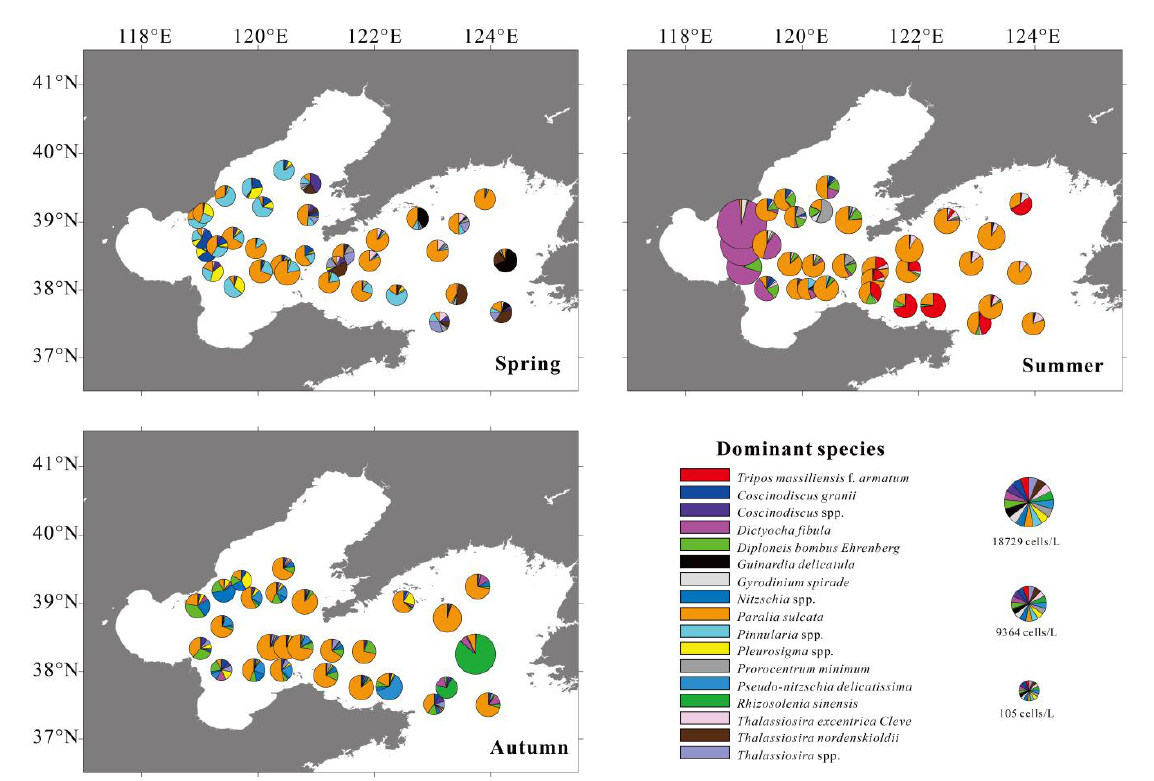
Figure 3. Pie charts of the top 15 dominant phytoplankton taxa in different seasons based on water column integration. The pie chart size is related to cell density as shown in Figure 3.